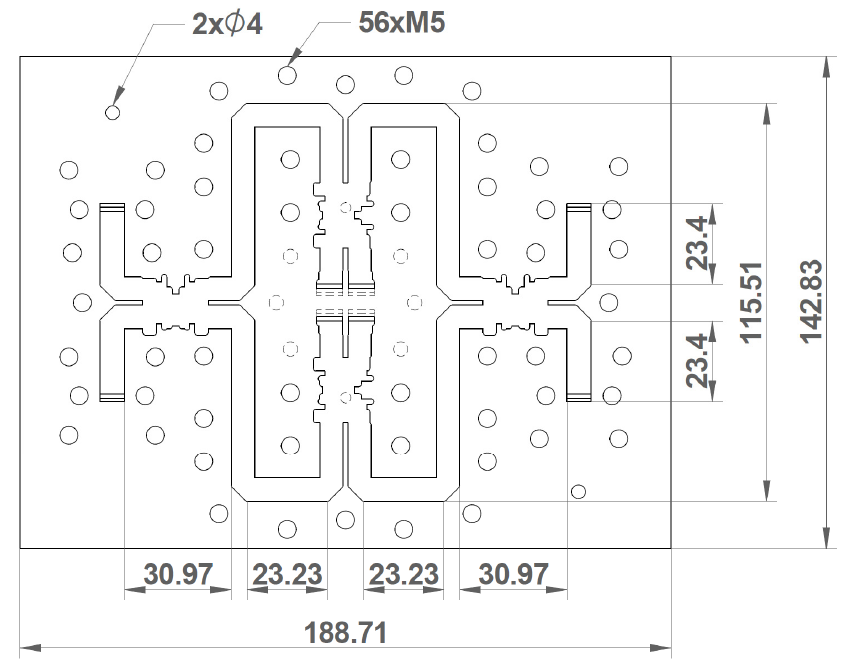
Figure 2. Top view of the comparator network. The rounding of the corners produced by the drill is included in the drawing, as well as the holes for inserting the screws and alignment pins. The main dimensions of the component, in millimeters, are annotated.